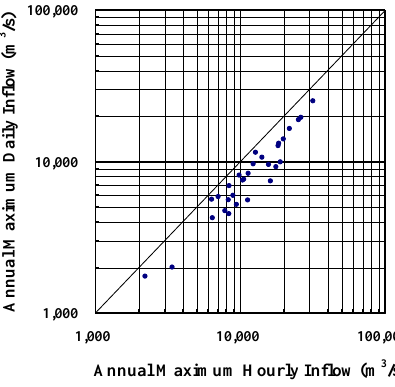
Figure 11. Annual Maximum Series of Hourly and Daily Observed Inflow at the Paldang Dam.